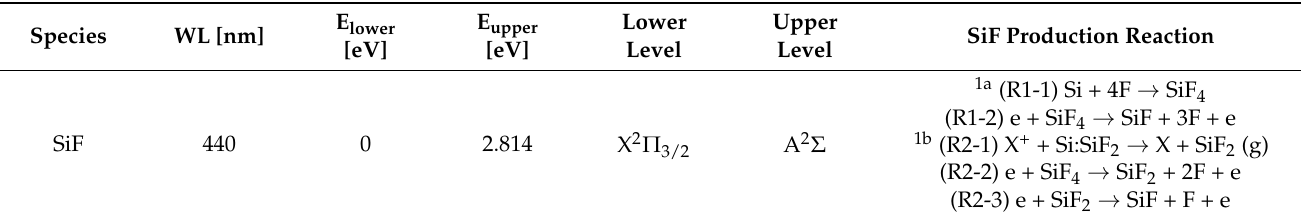
Table A2. Optical emission spectrum information and production reaction of silicon fluoride (SiF)